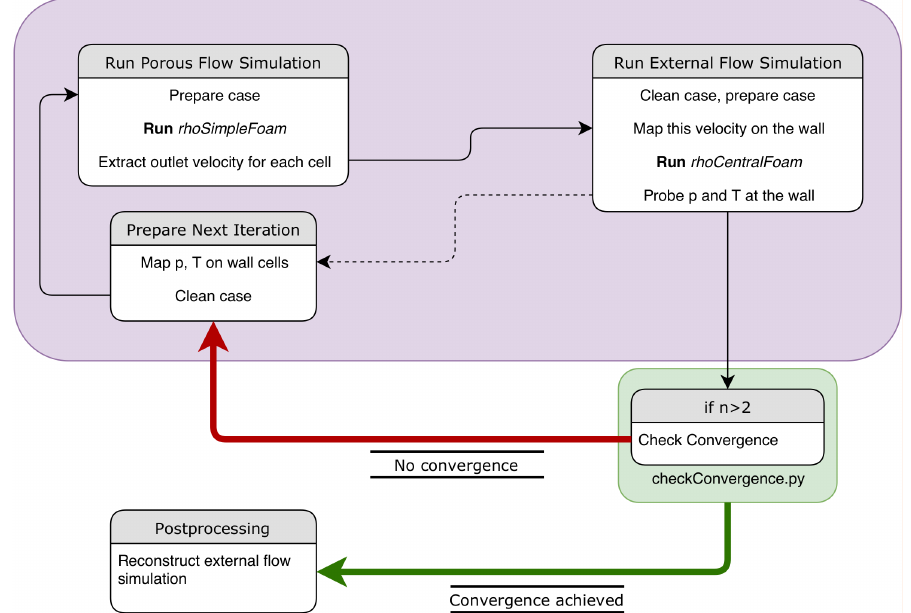
Figure 2. Flowchart of the coupling